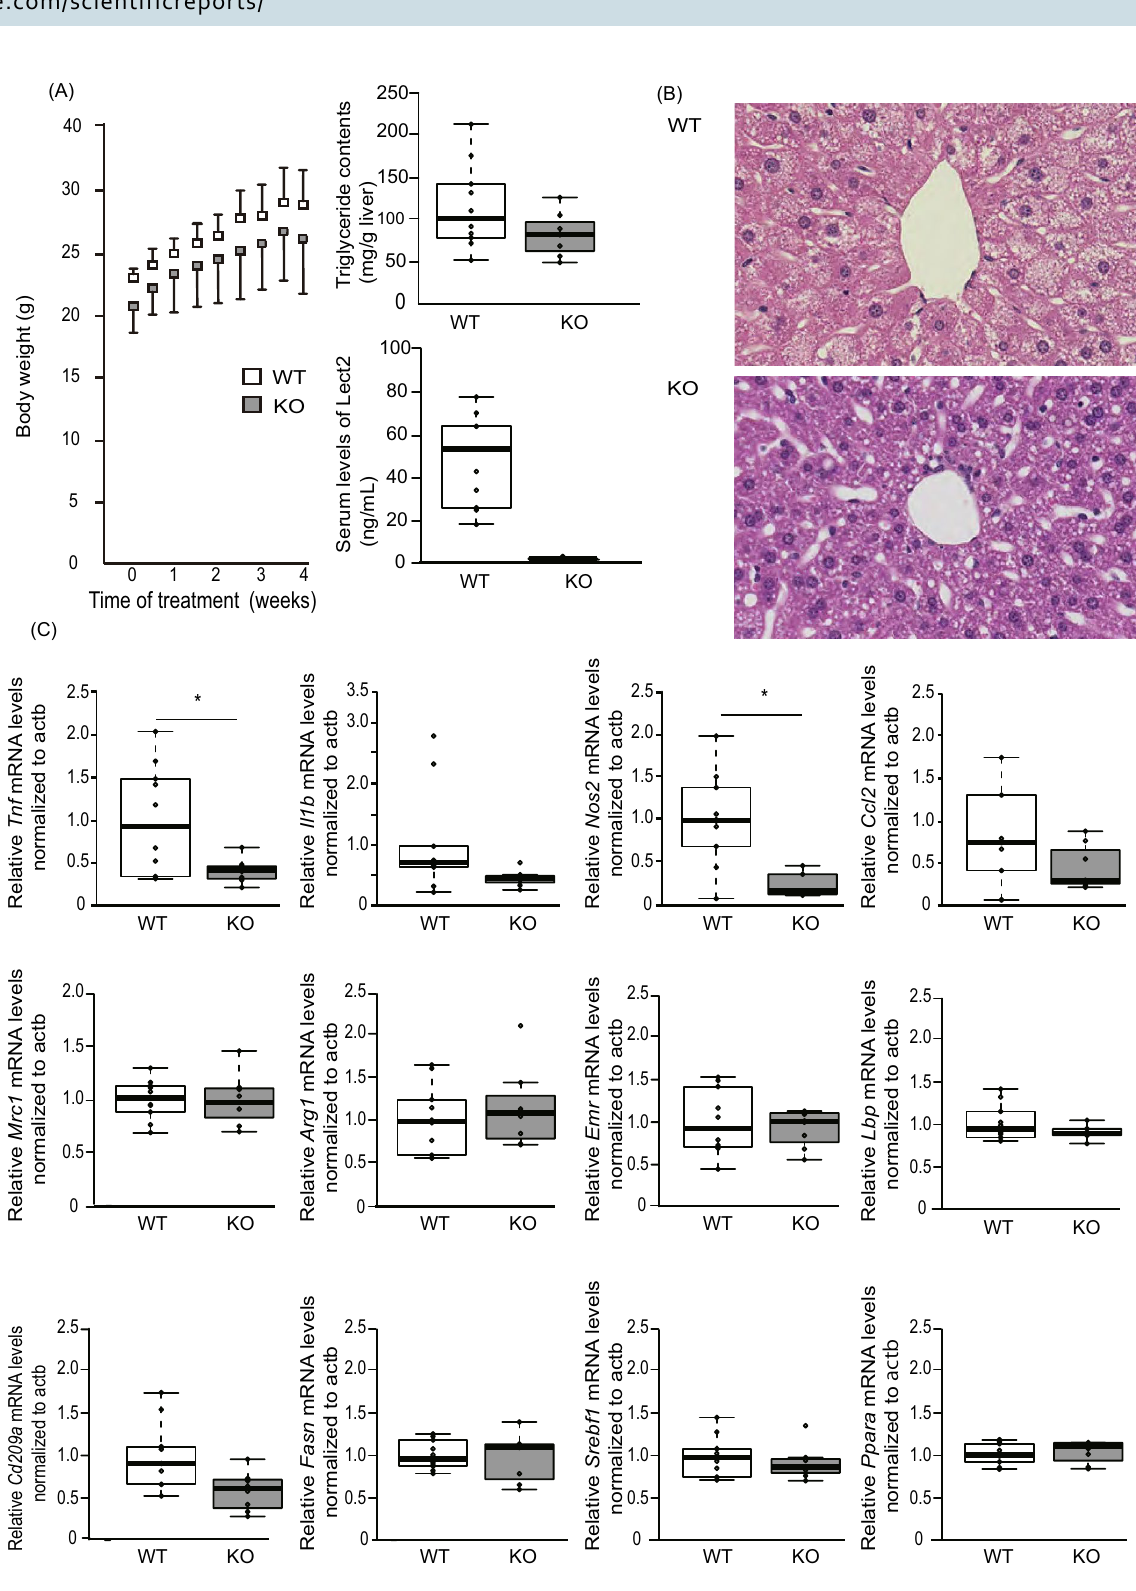
Figure 2. Lect2 KO mice attenuate diet-induced inflammation in the liver. ( A ) Graph shows bodyweight of Lect2 KO and wild-type mice fed an HFHS diet. 8 week-old-male mice were fed an HF diet for 4 weeks (n = 7–10). The graph shows the liver triglyceride content of Lect2 KO and wild-type mice fed an HF diet. 8 week-old-male mice were fed an HF diet for 4 weeks (n = 7–10). Blood levels of LECT2 from Lect2 KO and wild-type mice following fasting for 12 h. 8 week-old-male mice were fed HF diet for 4 weeks. ( B ) Hematoxylin and eosin staining of liver from Lect2 KO and wild-type mice fed an HF diet. 8 week-old-male mice were fed an HF diet for 4 weeks (n = 7–10). ( C ) Graphs show mRNA levels of genes involved in inflammation and lipid metabolism in the liver of Lect2 KO and wild-type mice fed an HF diet. 8 week-old-male mice were fed an HF diet for 4 weeks. *P <